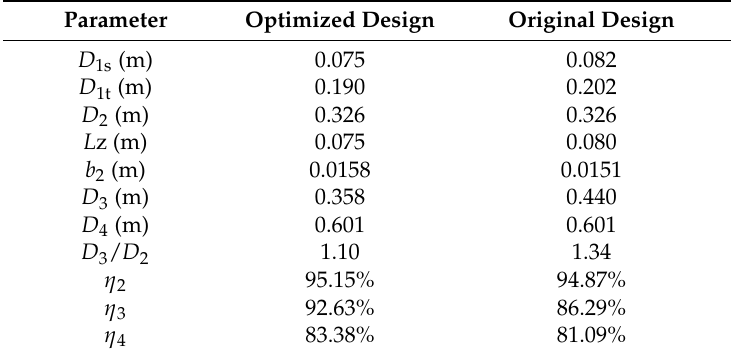
Table 1. Comparison of the parameters of the optimized and original